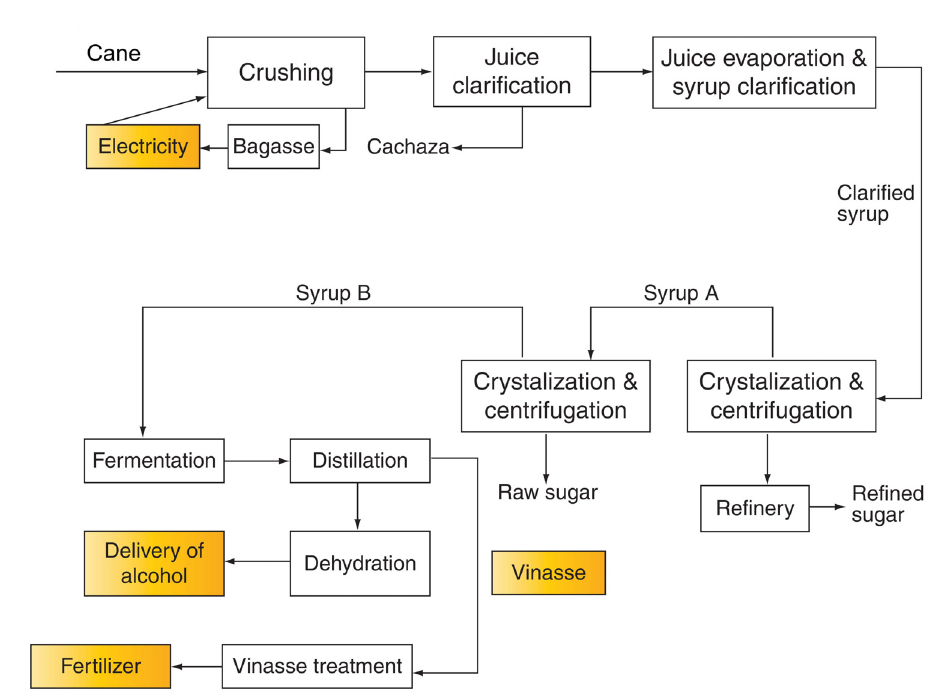
Figure 1. Process in a sugarcane milling plant